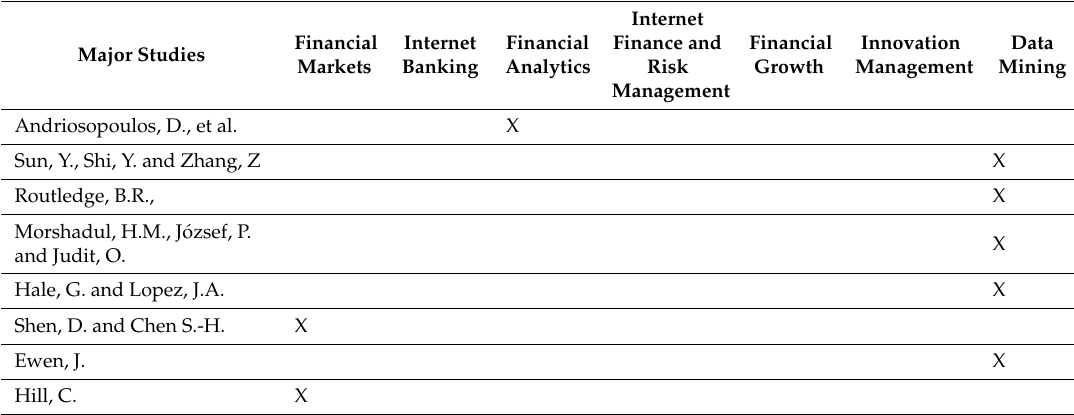
Table 3. Total number of published articles on the basis of academic fields, by